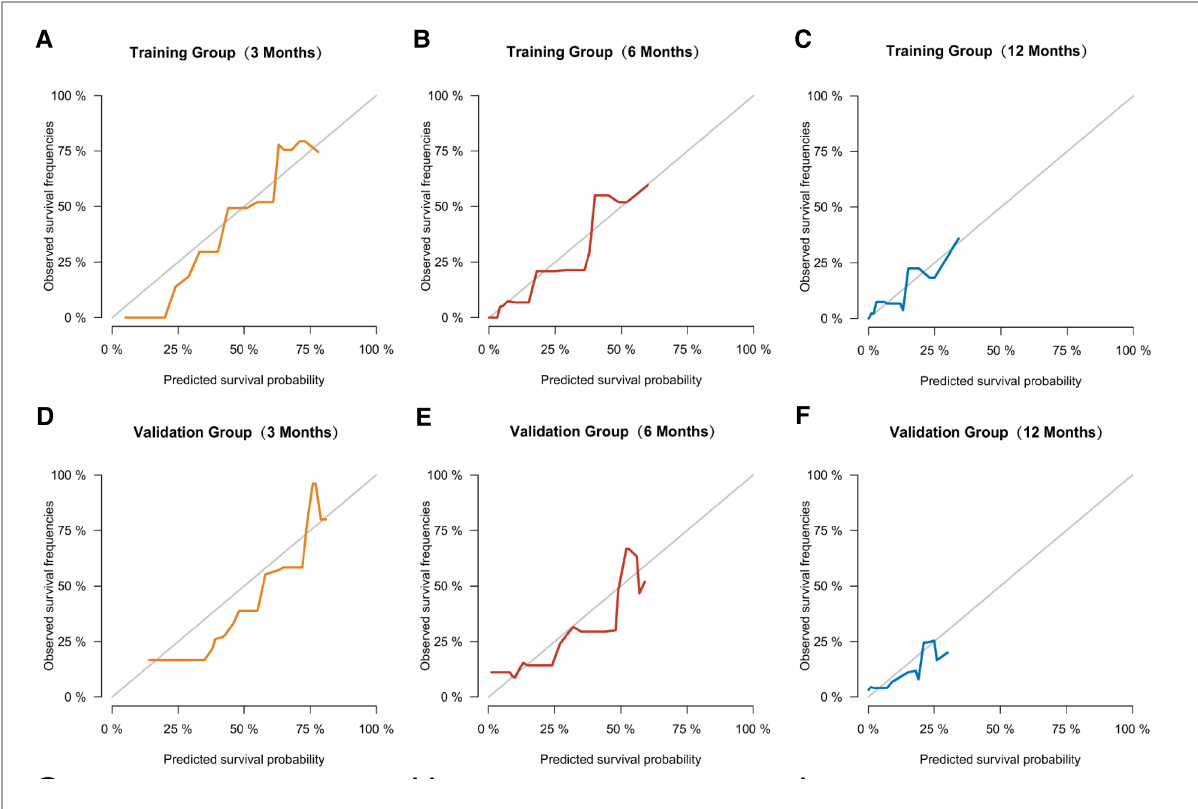
FIGURE 8 Calibration curves of the prognostic model at 3 ( A ), 6 ( B ), and 12 months ( C ) in the training group, and at 3 ( D ), 6 ( E ), and 12 months ( F ) in the validation